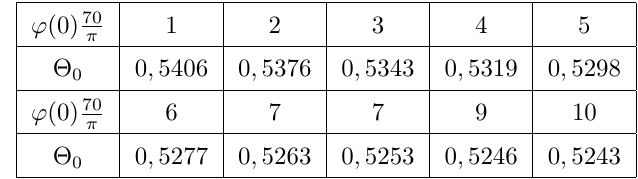
Figure 9 . Metric constant ’ -values of the non-abelian model.